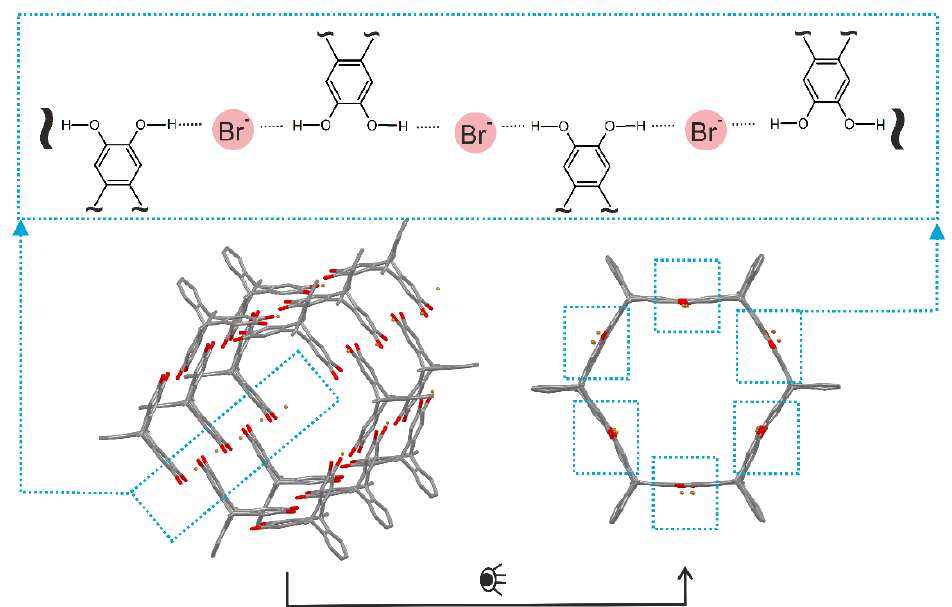
Figure 5. The tetrahydroxytriptycene molecule and a three-dimensional nanotube architecture, which is possible due to the weak O–H∙∙∙Br − hydrogen bonds [162] .